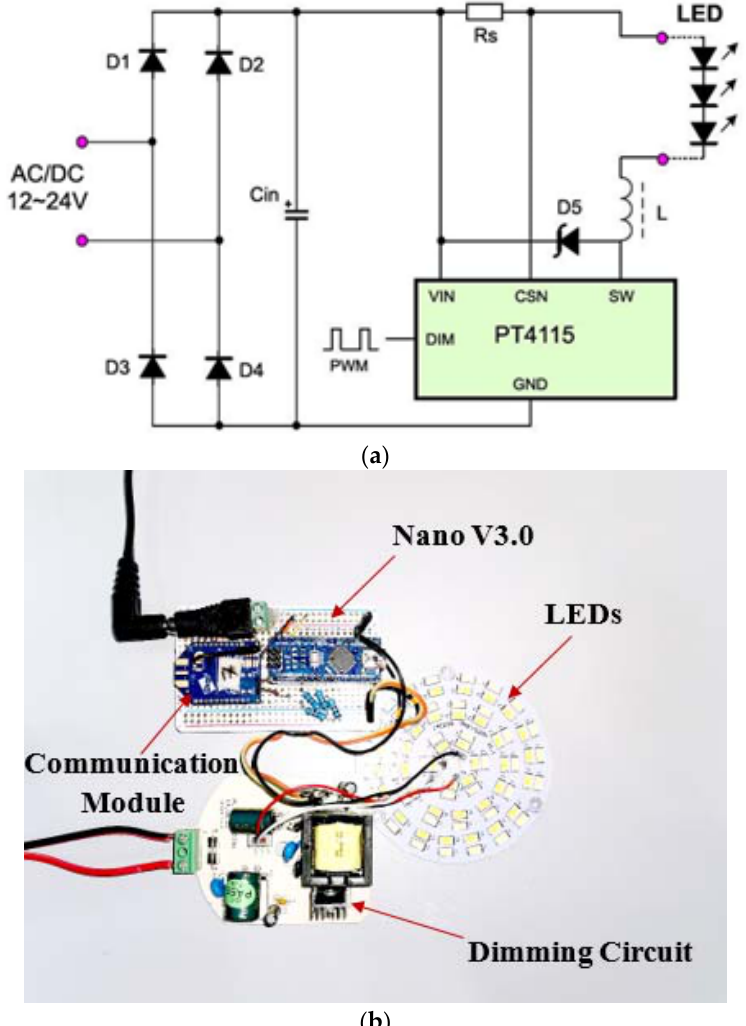
Figure 6. LED light dimming circuit: ( a ) Schematic and ( b ) Circuit connections.